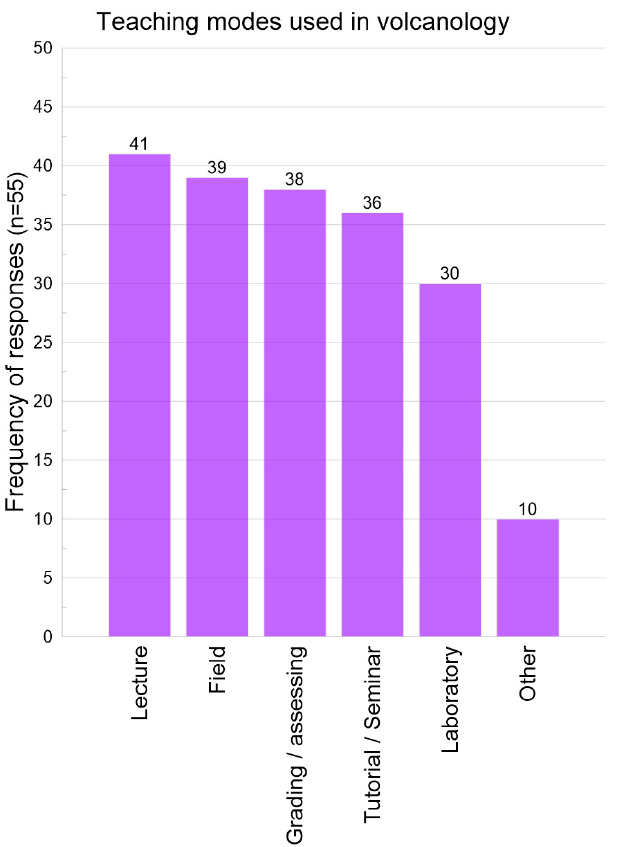
Figure 1: Modes of teaching employed in volcanol- ogy instruction by respondents. Note that respondents could select multiple options.